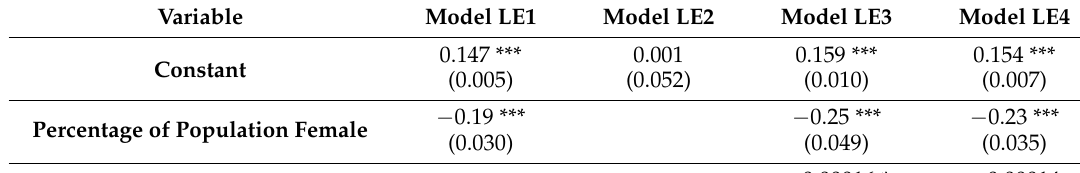
Table 5. Factors influencing life expectancy in Jordan